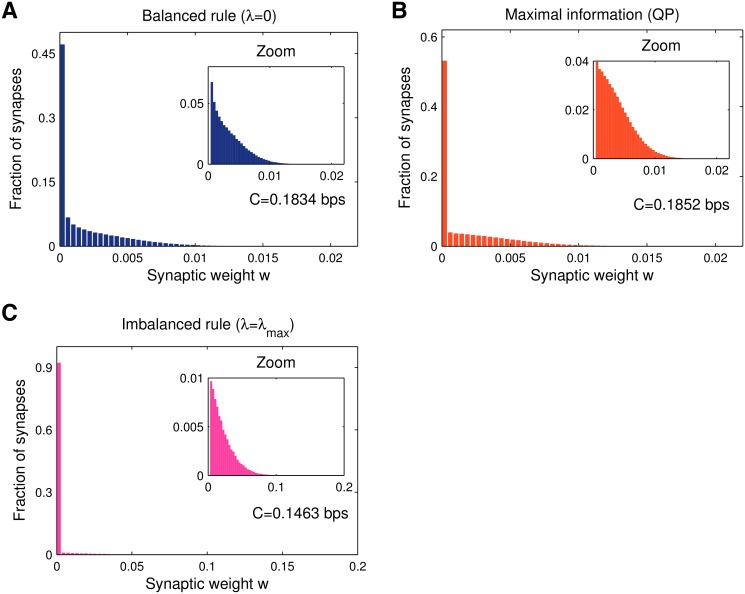
Synaptic weight histograms, information and memory efficiency at low memory load (α = 0.1).Data obtained averaging over a thousand simulations (N = 1000). A. For balanced learning the distribution is stretched due to the optimised learning (large threshold choice θ = 1 under a small learning rate ε = 1/N). As with the non-negative perceptron classifier [28], a large number of zero synapses appear. B. Maximal-information solution obtained via quadratic programming, with the objective set at minimising the Euclidean norm ∣∣w∣∣2. The quadratic objective function leads to a hemi-Gaussian weight distribution, again with a large fraction of silent synapses arising from the non-negativity constraint. C. Minimal linear norm solution (largest imbalance). As the learning task is ‘easy’ (low α), strong depression leads to a highly sparse synaptic configuration.